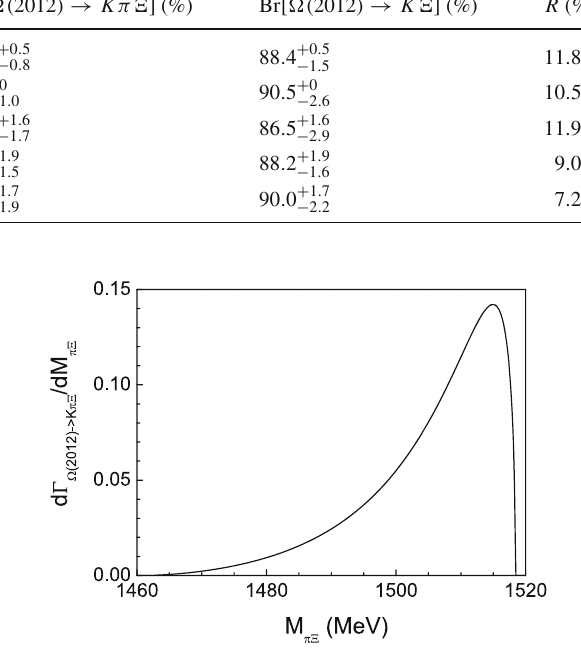
Fig. 4 The π(cid:3) invariant mass distribution of the three body decay of (cid:2)( 2012 ) → ¯ K (cid:3) ∗ ( 1530 ) → ¯ K π(cid:3) . The numerical results are obtained with the parameters of set I